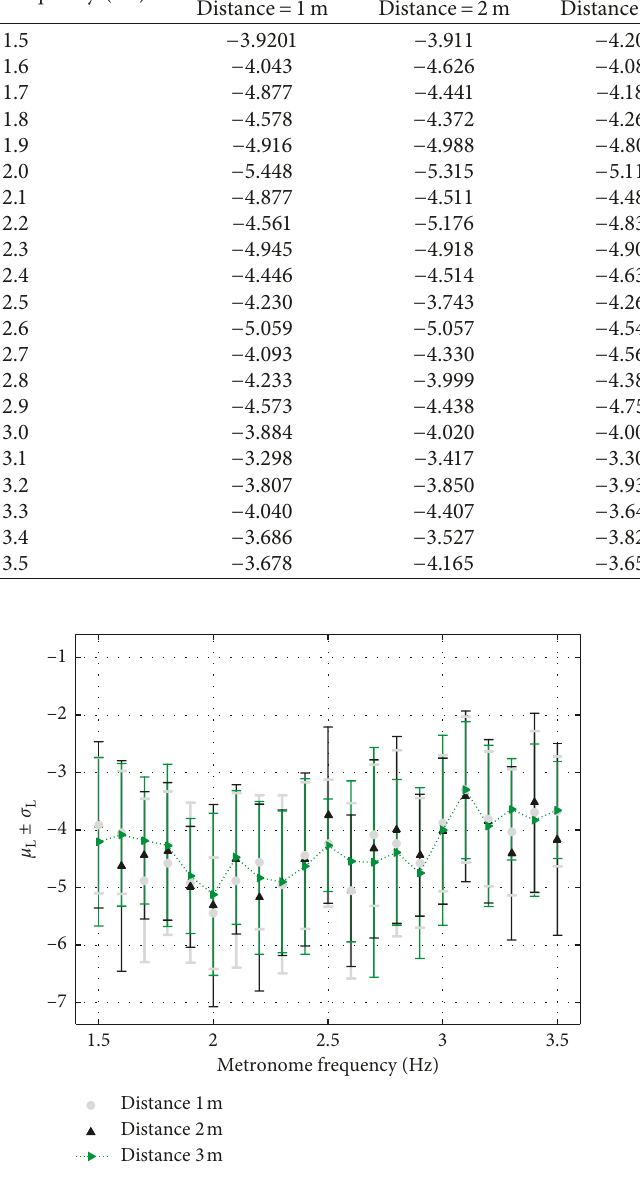
Figure 23: Error bar of lognormal distribution parameters of coherence coefficients in the frontal direction. Table 6: Coherence coefficients of a single participant (bold) with others at 1.8Hz